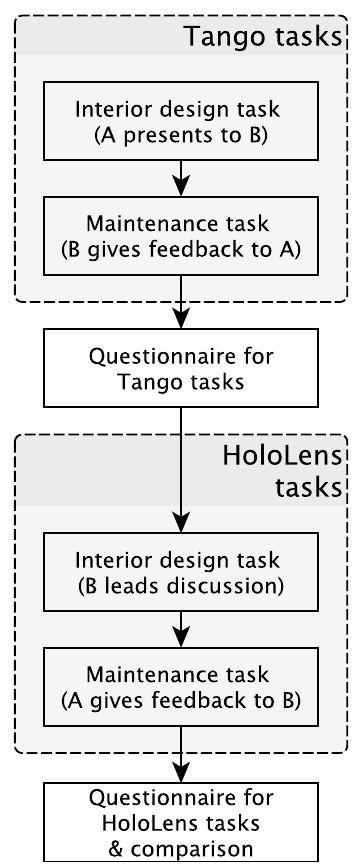
Figure 4. Flowchart visualising the main tasks of the user study. A and B are the